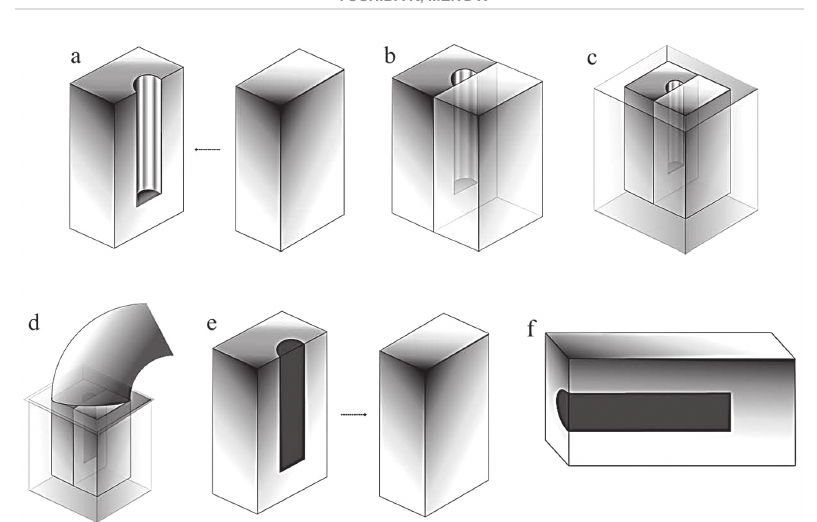
Figure 1- Schematic illustration of the preparation of specimens for measurement of Knoop hardness: a: acrylic resin blocks (5x10x16 mm) with or without semi-cylindrical cavity (diameter of 3 mm and depth of 11 mm); b: two acrylic resin blocks joined; c: two acrylic resin blocks placed in a silicon impression material mold (15x15x20 mm); d: dual-cured core build-up resin composite filled in the cavity and irradiated on the upper surface using LED light unit; e: two acrylic resin blocks separated; f: Knoop hardness measurement for the surface of resin composite filled in the semi-cylindrical